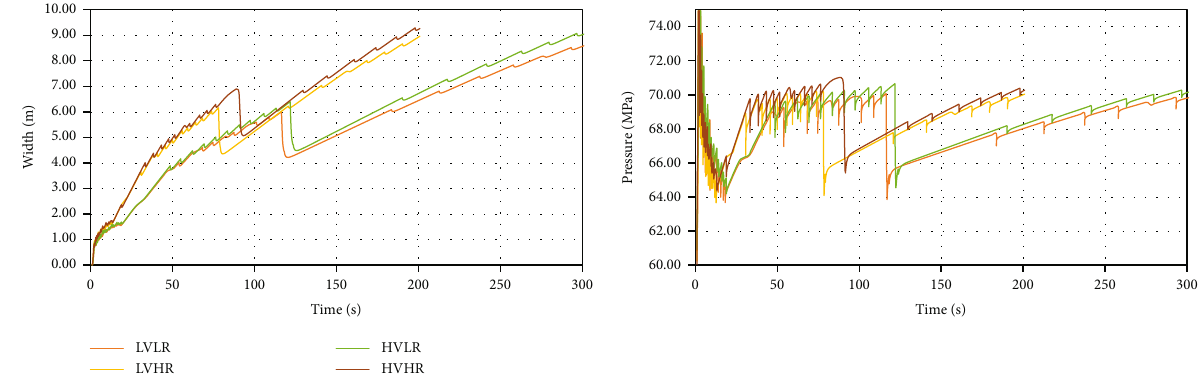
Figure 15: The in fl uence of fl uid viscosity and injection rates on injection pressure and fracture width.